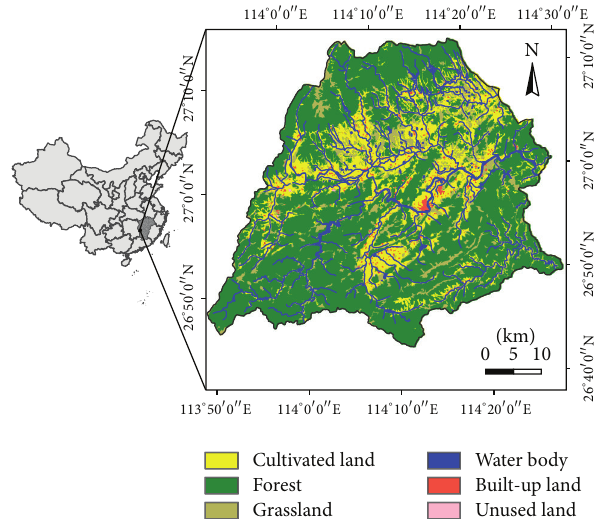
Figure 1: Location of Yongxin County and the distribution map of